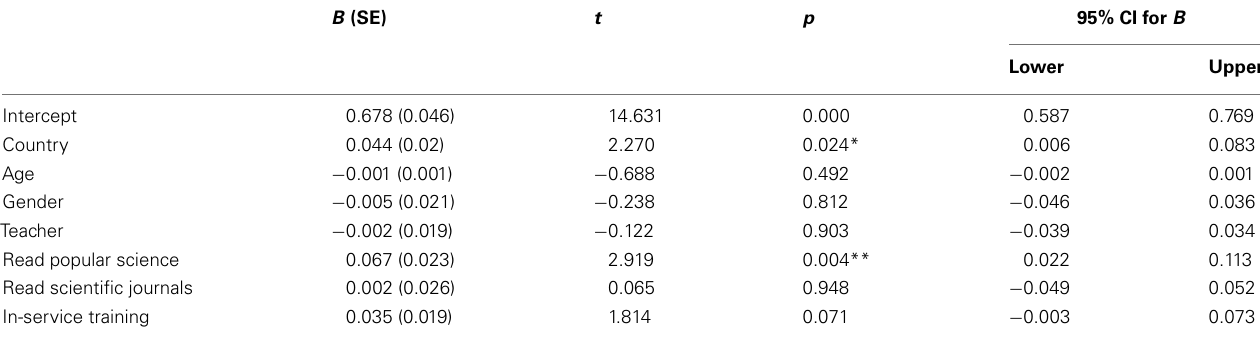
Table 4 | Predictors of general